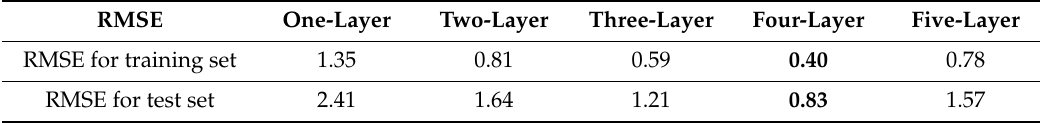
Table 2. The RMSE of di ff erent layers of the LSTM for the training set and test set.